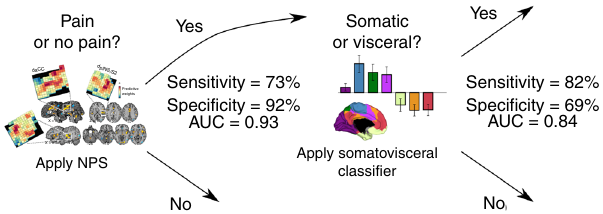
Fig. 6 Overview of the proposed two-stage pain classi fi cation process based on the potential biomarkers validated and developed in this paper. First, the NPS is applied as a classi fi er for pain/no pain. Subsequently, if the decision is “ pain ” , a somatovisceral pain classi fi er is applied to determine the pain modality/type. AUC, area under the receiver operating characteristic curve in validation tests. AUC is a threshold-free measure of accuracy. Visualization of the NPS adapted from Woo et al. 20